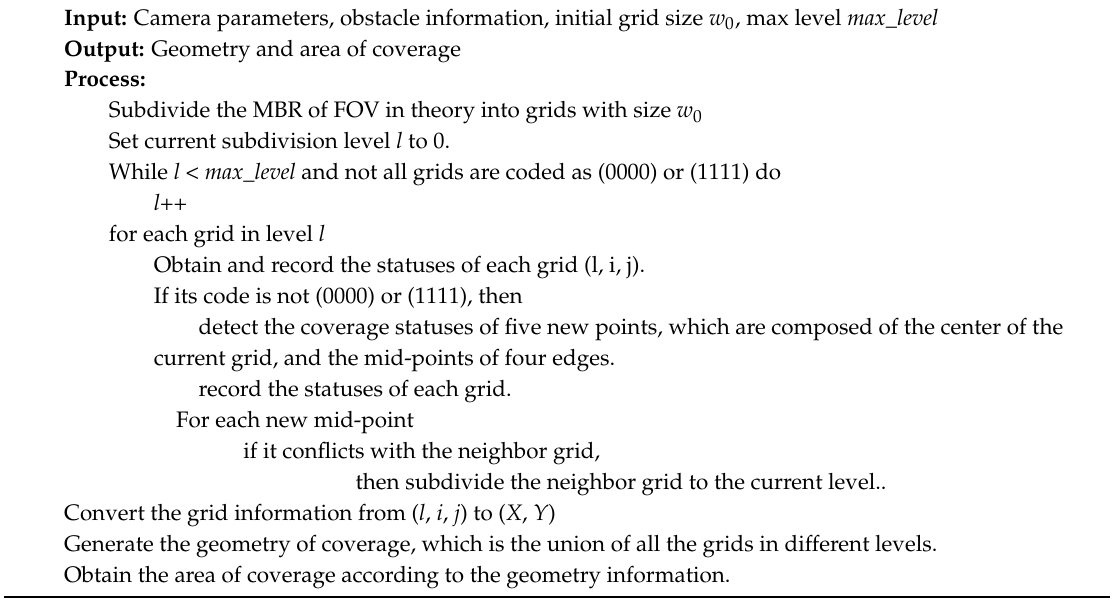
Algorithms 1 : Camera Coverage Estimation Based on Multistage Grid